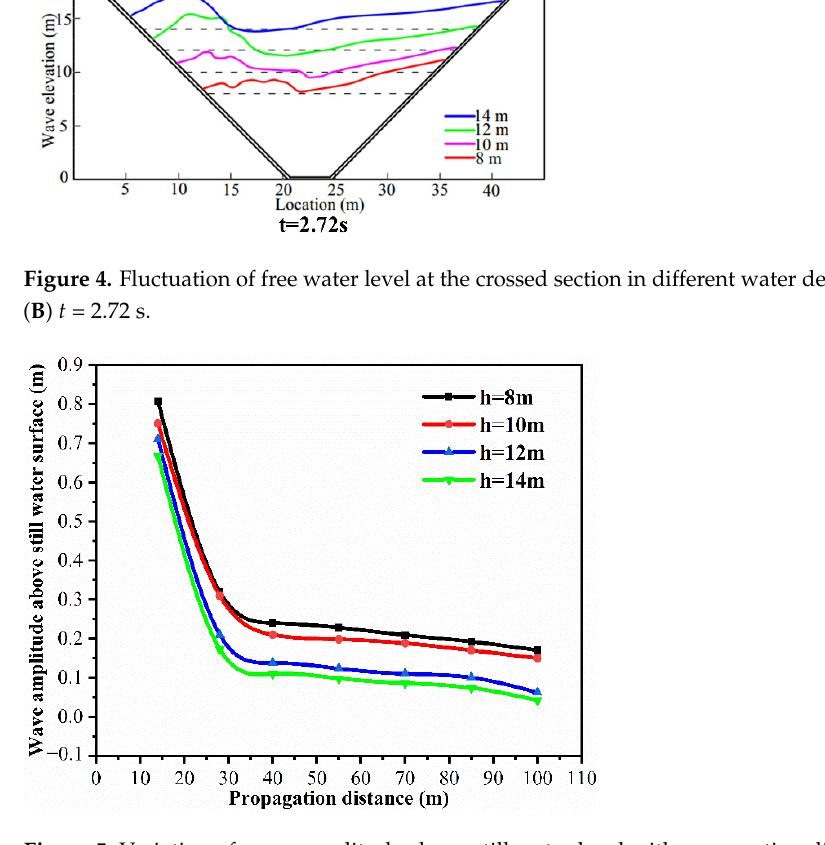
Figure 4. Fluctuation of free water level at the crossed section in different water depths: ( A ) t = 0.69 s; ( B ) t = 2.72 s.